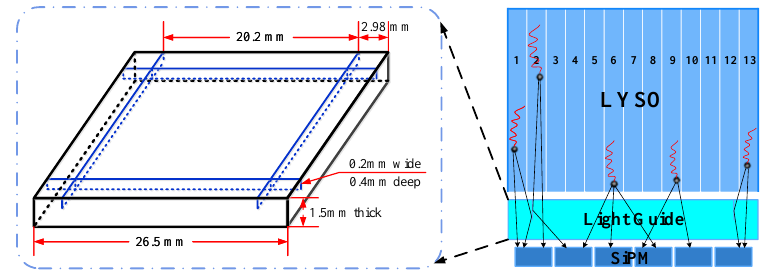
Figure 4. Illustration of the semi-cut light guide design and the photon transport in edge crystals with the semi-cut light